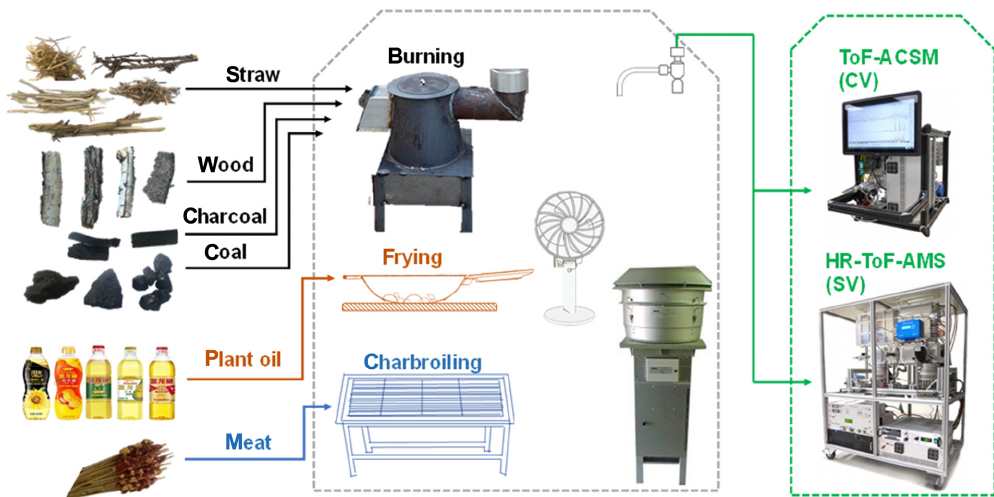
Figure 1. Schematic of cooking and burning experiments.